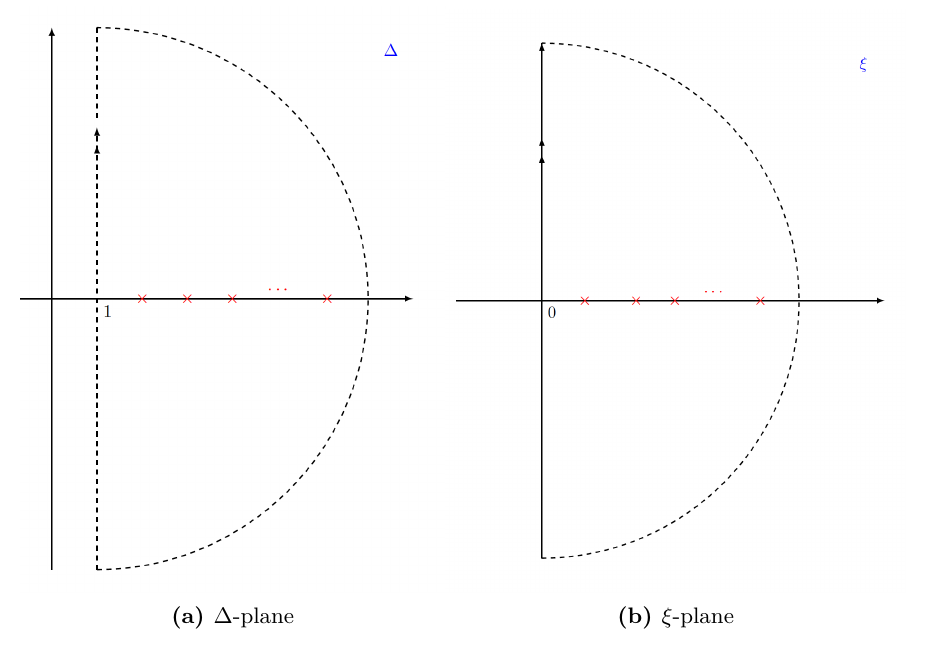
Figure 1. The contours in the ∆ -plane and ξ